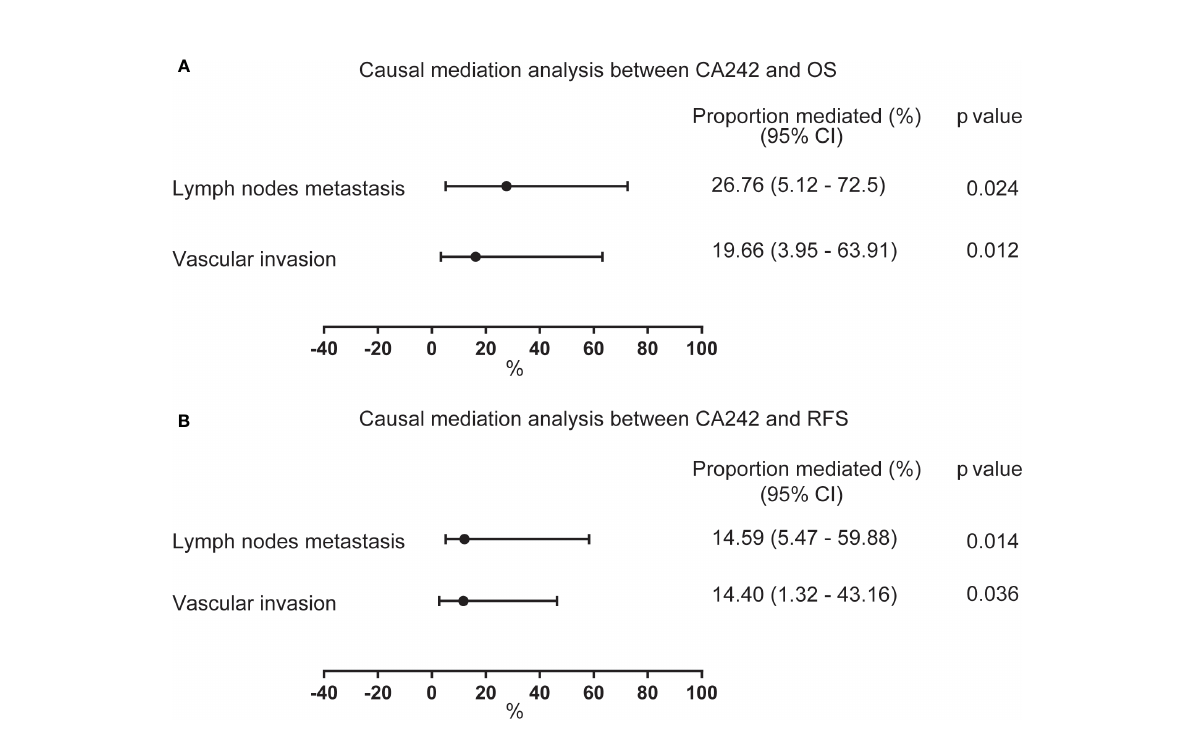
FIGURE 2 The forest plot showing the proportion mediated by vascular invasion and lymph node metastasis between CA242 and OS/RFS. (A) The average proportion mediated by lymph node metastasis and vascular invasion between serum elevated CA242 levels and OS. (B) The average proportion mediated by lymph node metastasis and vascular invasion between serum elevated CA242 levels and